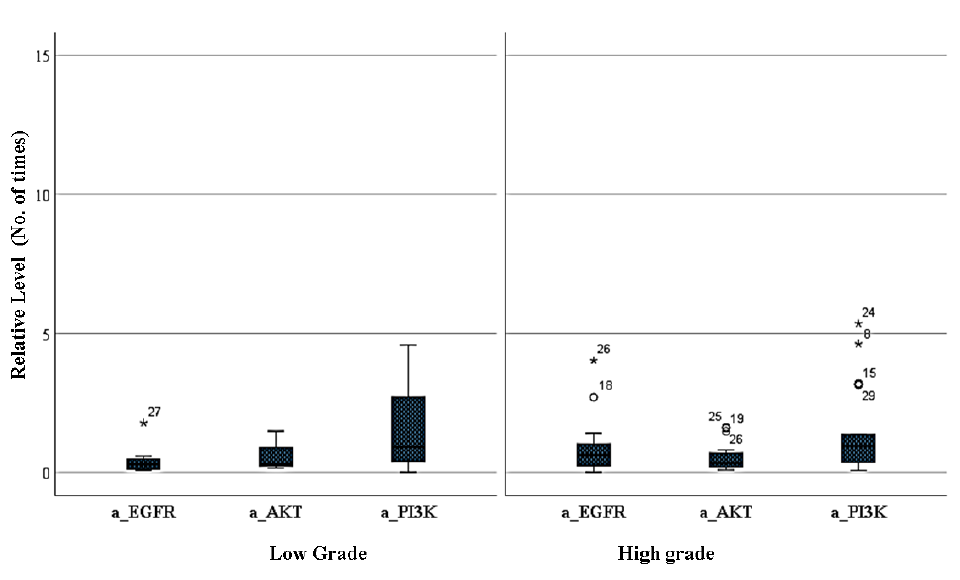
Figure 1. Relative Amplification of EGFR, PI3K, and AKT in low and high gliomas. Gene amplification analysis was performed for EGFR; PI3K, and AKT. An increase in EGRF was observed in high-grade gliomas and PI3k/AKT in low-grade gliomas, however, no statistically significant differences in copy number were observed. Each sample was analyzed in triplicate. A standard curve was performed for the reference gene (beta-actin). Gene amplification was determined by using the ΔΔ CT comparative method having beta-actin as an endogenous control. Asterisks and circles show the samples with the highest level of expression in each group.